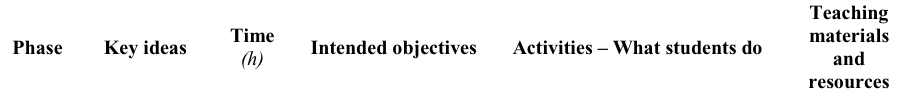
Table 1: Overview of the “Stars and their functioning” student’s activities.